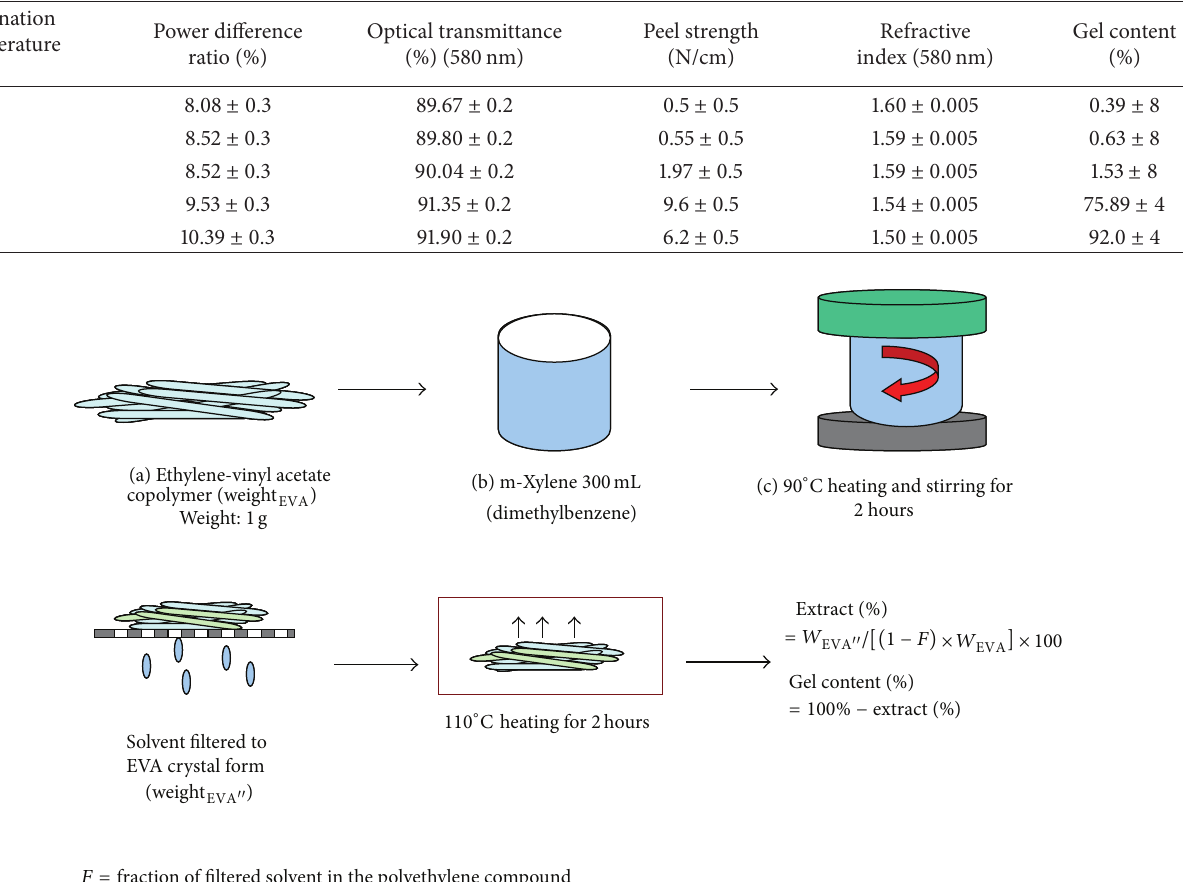
Figure 3: The experimental process of gel content